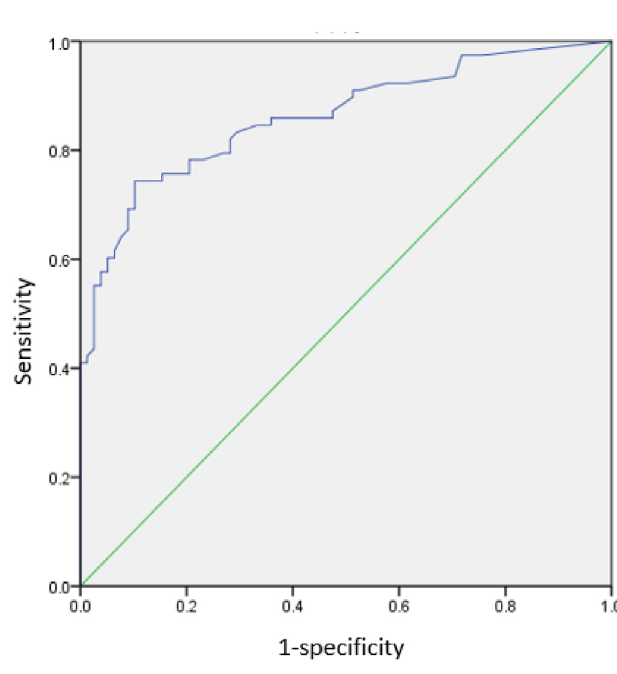
Fig. 3 – Discrimination of the logistic regression model for the risk of acute kidney injury renal replacement therapy (AKI-RRT) in the matched